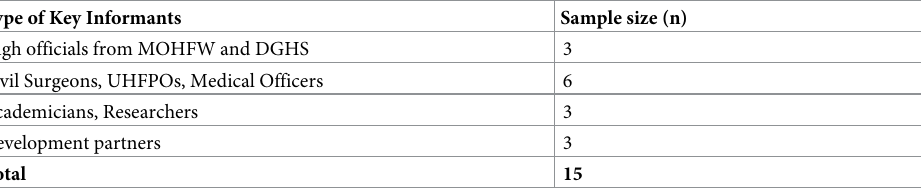
Table 1. Sample size and type of key informants